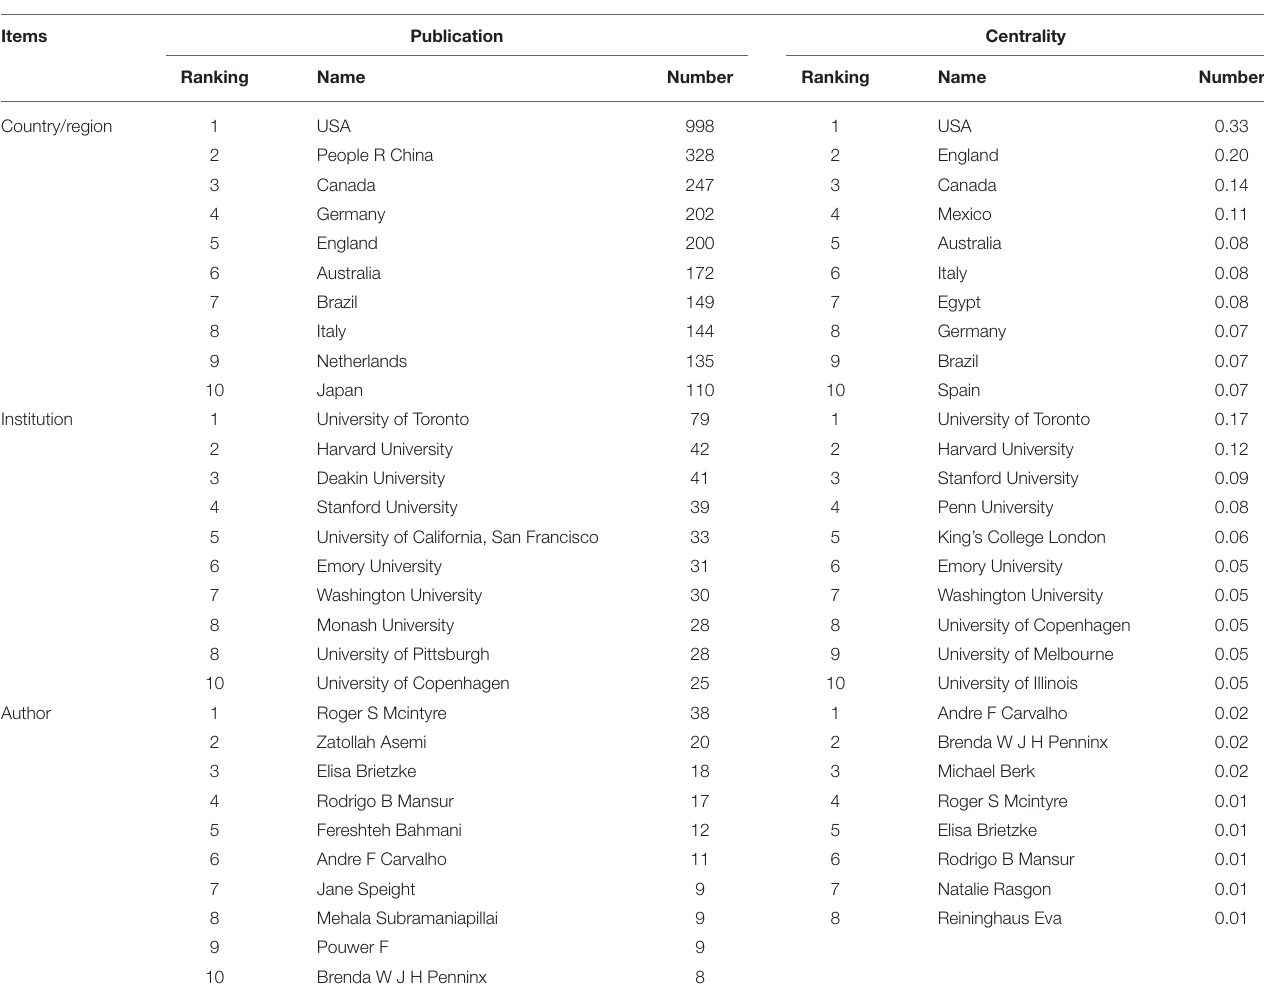
TABLE 1 | Top 10 countries/regions, institutions, and authors in terms of publications and centrality.